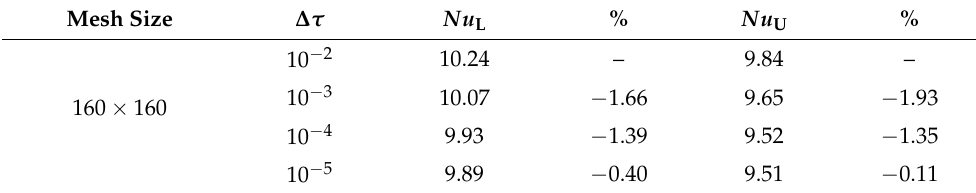
Table 2. Time-step sensitivity analysis for W / H = 0.5, L / H = 0 and Ra H = 10 5 . Mesh Size ∆ τ Nu